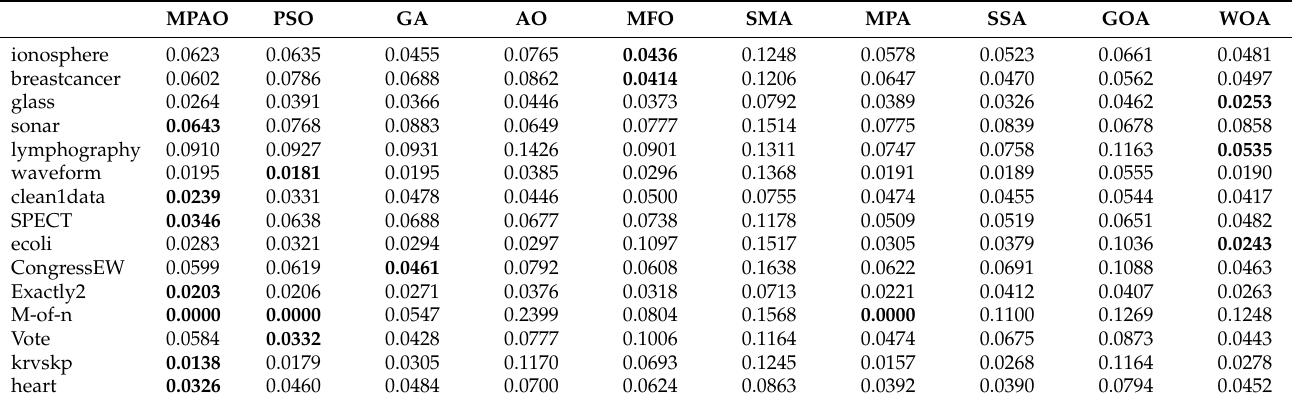
Table 10. Results of the standard deviation of the fitness value.